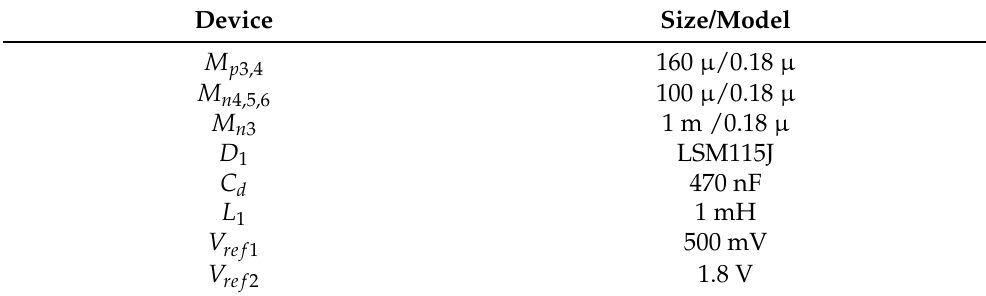
Table 2. The information of RF rectifier and DC-DC boost converter.